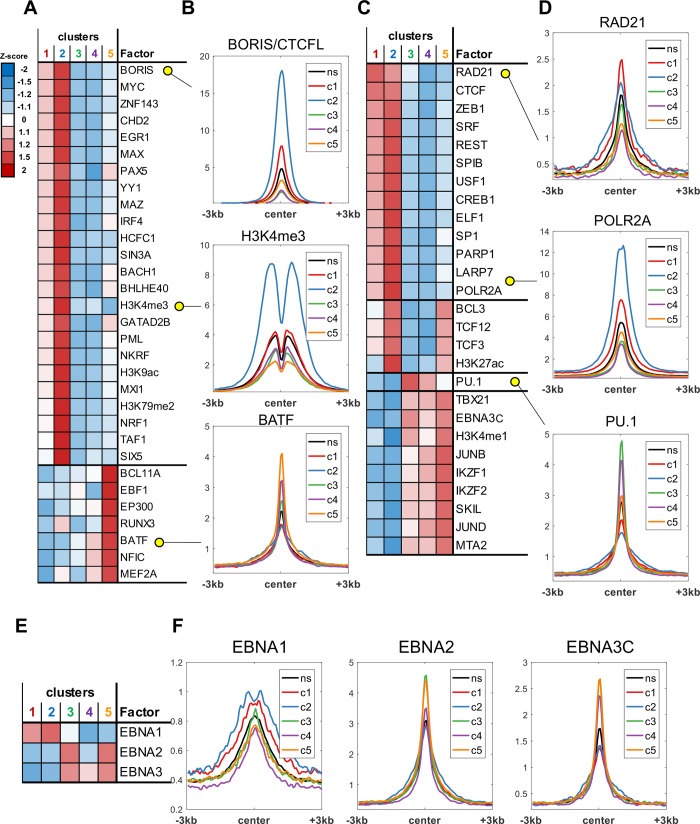
Transcription factor-mediated regulation of chromatin accessibility.Publicly available LCL ChIP-seq datasets were used to derive average binding signal of various factors and histones within high confidence ATAC-seq regions. Heatmaps visualize distribution of mean ChIP-seq signal across clusters. Line plots show average signal profiles for each cluster (c1-c5) as well as non-significantly (ns) changed regions for select specific examples. Examples of factors with higher binding within a single cluster (A) and associated line plots (B) are shown, as well as examples of factors with increased binding in multiple clusters (C, D). (E-F) Distribution of ChIP-seq signal across ATAC-seq clusters for EBNA1, EBNA2, and EBNA3C.